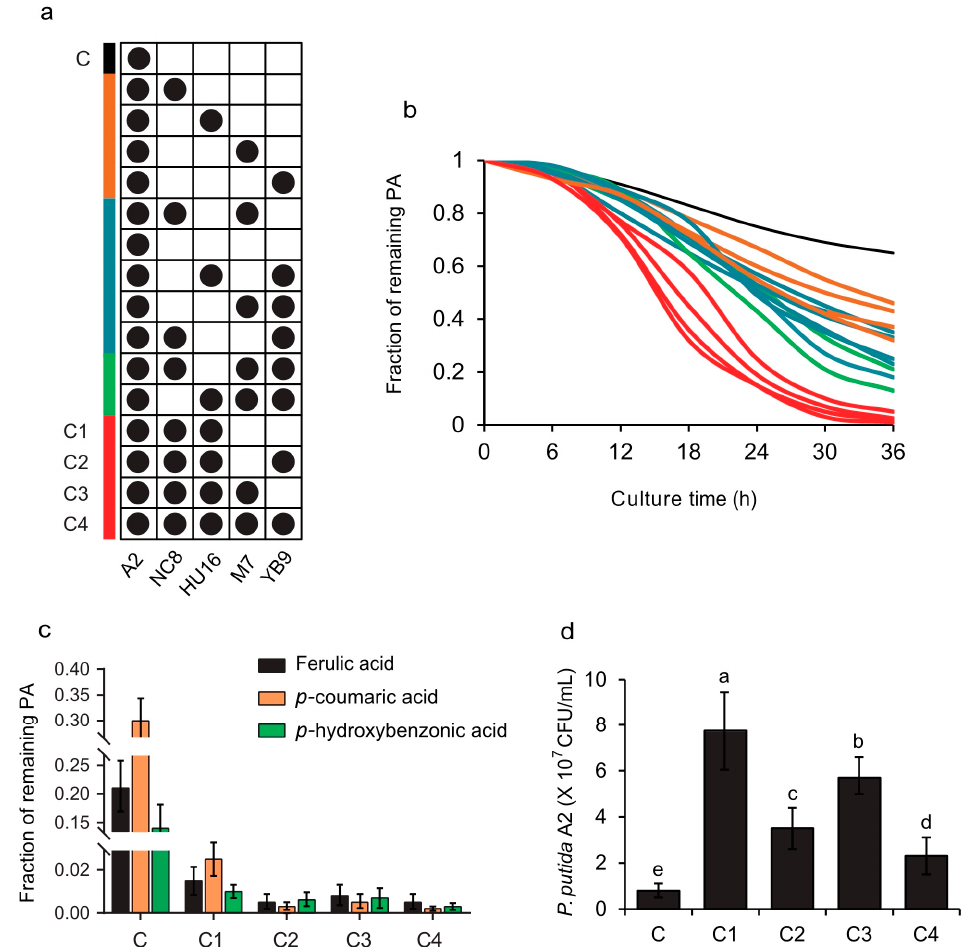
Figure 7. Assays of PA-degradation and P. putida A2 growth in di ff erent combinations. Line colors represented di ff erent combinations, as indexed in the right grid. PA-degradation performances of 16 combinations ( a ). In vitro PA degradation and A2 growth performance in inorganic media with 0.9 g / L mixed PAs (ferulic, p -coumaric and p -hydroxybenzonic acids, 1:1:1). During 36 h of culture, the remaining PAs was measured at di ff erent time points ( b ). At 36 h of culture, the remaining PAs ( c ) and A2 growth performance ( d ) were measured in the C-C4 combinations. C, A2 only; C1, combinations of A2, NC8 and HU16; C2, combinations of A2, NC8, HU16 and YB9; C3, combinations of A2, NC8, HU16 and M7; C4, combinations of A2, NC8, HU16, M7 and YB9. Data are means ± SE. Di ff erent letters above the bars indicate statistically significant di ff erences at p < 0.05 by Tukey’s HSD test.